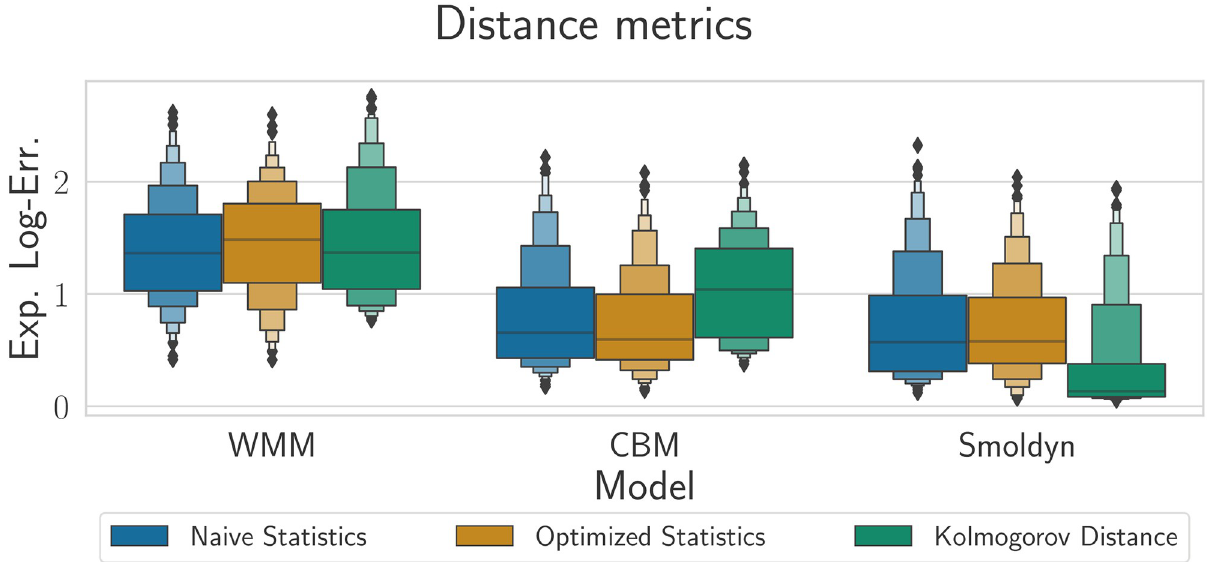
Fig 5. Boxen plots of expected log-error for WMM (blue), CBM (yellow) and Smolydn (green) models respectively when used with Naive statistics, optimized statistics and Kolmogorov distance metrics. There is general convergence when adding more details to the model, although for a given model, no metric is consistently more accurate than the